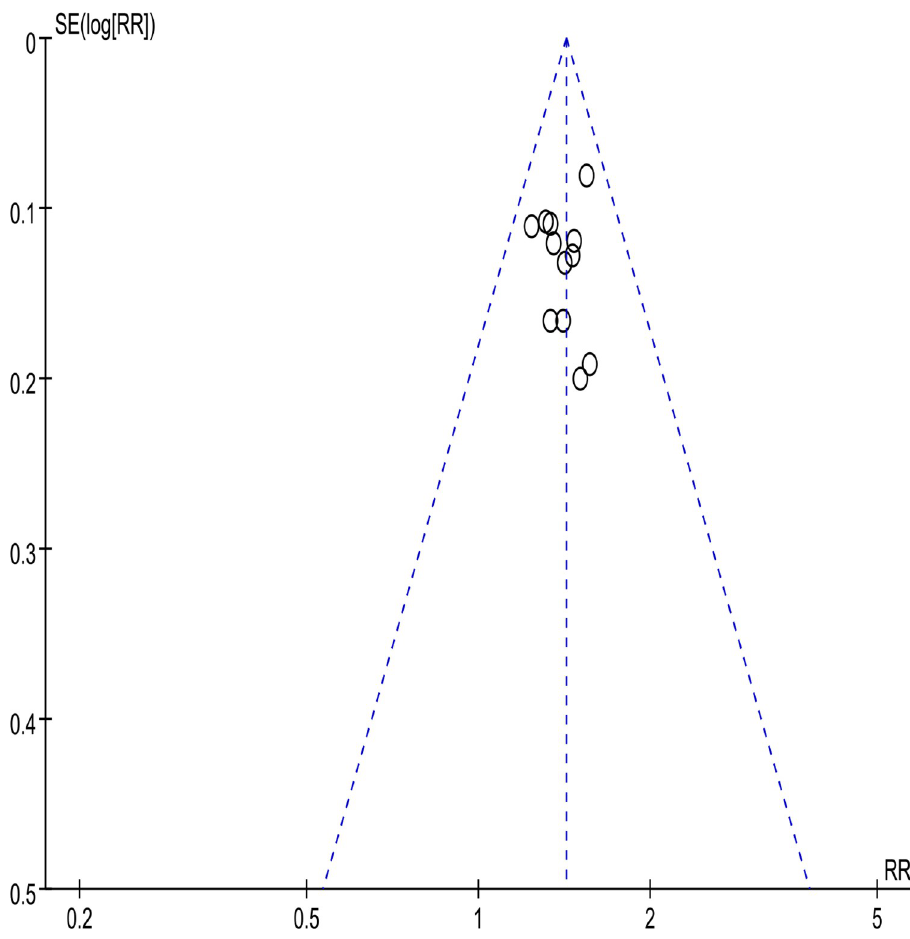
Fig 6. Funnel plot of clinical efficacy after excluding two studies.